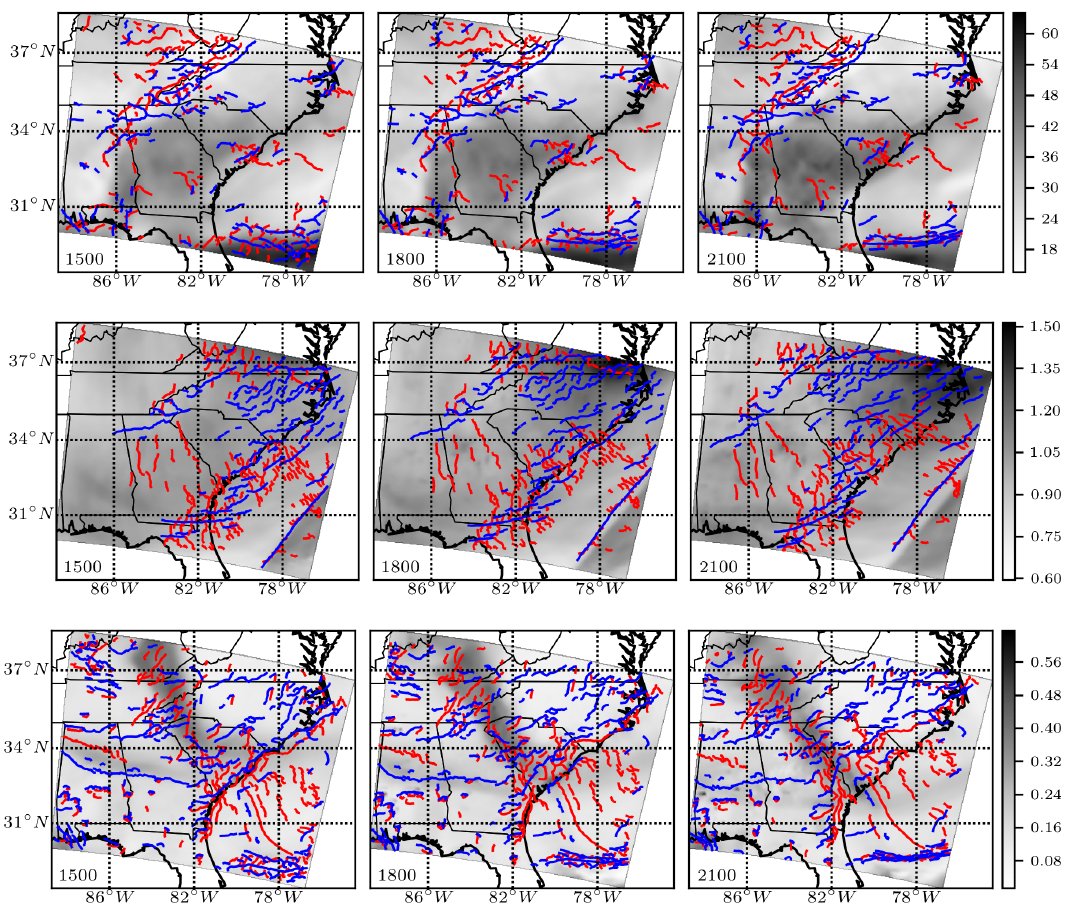
Figure 10. The grayscale field is the vertically-integrated species amount Q s for s = H 2 O (top panel), O 3 (middle panel), and Na + (bottom panel). The color bar at the right measures Q s in kg/m 2 for water vapor H 2 O and in mg/m 2 for ozone O 3 and sodium Na + . Superimposed on the Q s field are the attractive (blue) and repelling (red) instantaneous hyperbolic Lagrangian coherent structures, material lines within the flow where the attraction and repulsion of pollutant species are maximized. For each species, three snapshots in time are shown, 15:00, 18:00, and 21:00, from left to right. Superimposed on the Q s field are the attracting (blue) and repelling (red) instantaneous hyperbolic LCSs, material lines within the flow where the attraction and repulsion of each species will